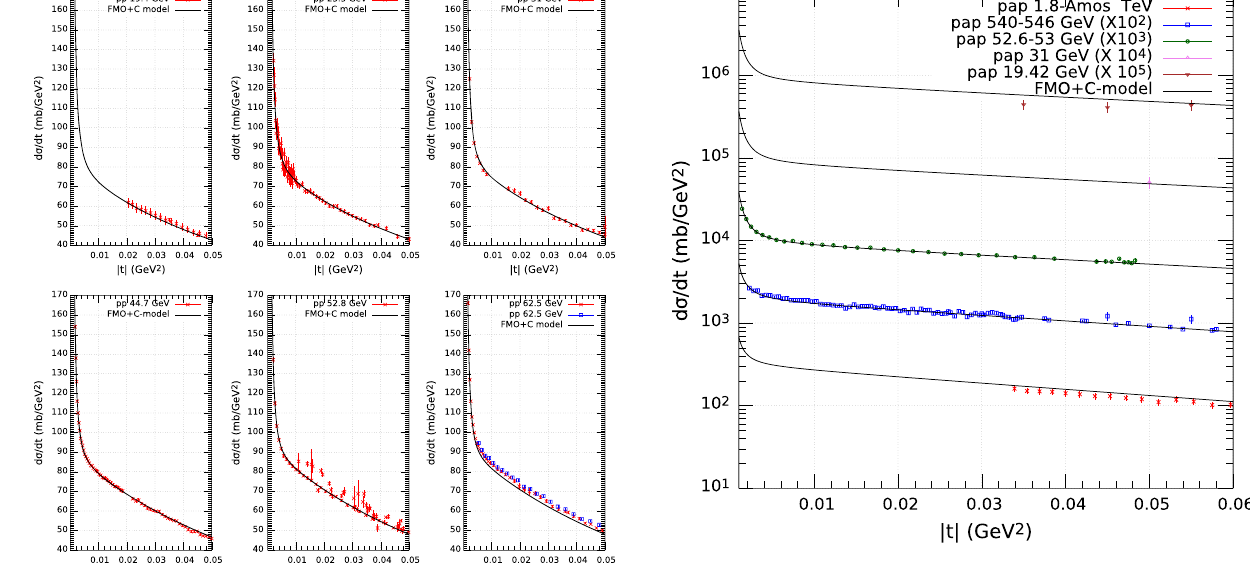
Fig. 7 Differential ¯ pp cross sections at the lowest | t | (parameters of the Froissaron and Maximal Odderon terms, of the standard Pomeron and Odderon, of the ”hard“Pomeron and Odderon, and of the secondary